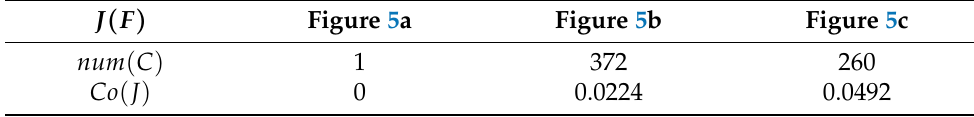
Table 1. num ( C ) and Co ( J ) of the three cases in Figure